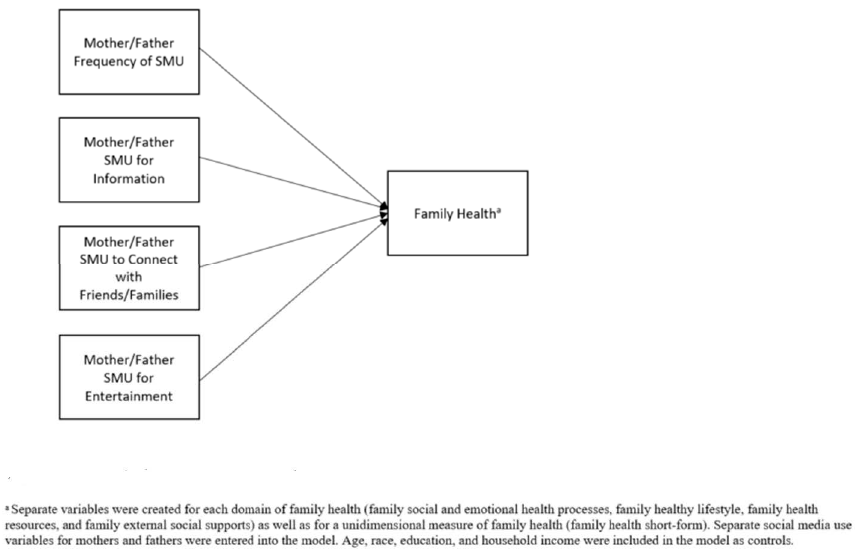
Figure 1. Conceptual Framework for the Relationship between Mother and Father Socail Media Use and Famliy Health. and Famliy